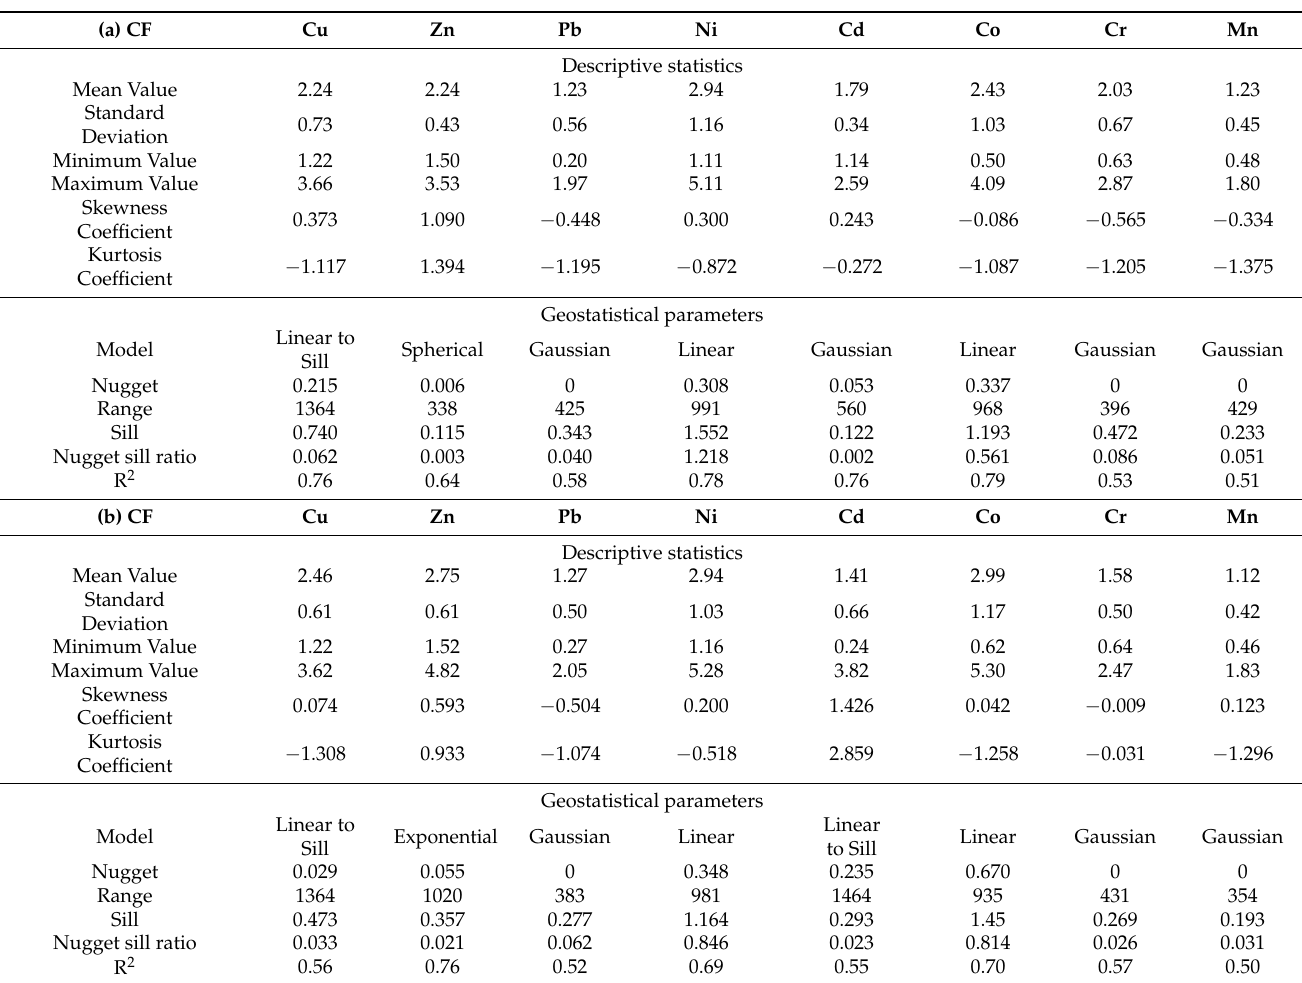
Table 3. (a) Descriptive statistics for the contamination factor (CF) before the COVID-19 pandemic— heavy metals; geostatistical parameters, for the creation and validation of the contour maps. (b) De- scriptive statistics for the contamination factor (CF) during the COVID-19 pandemic—heavy metals; geostatistical parameters, for the creation and validation of the contour